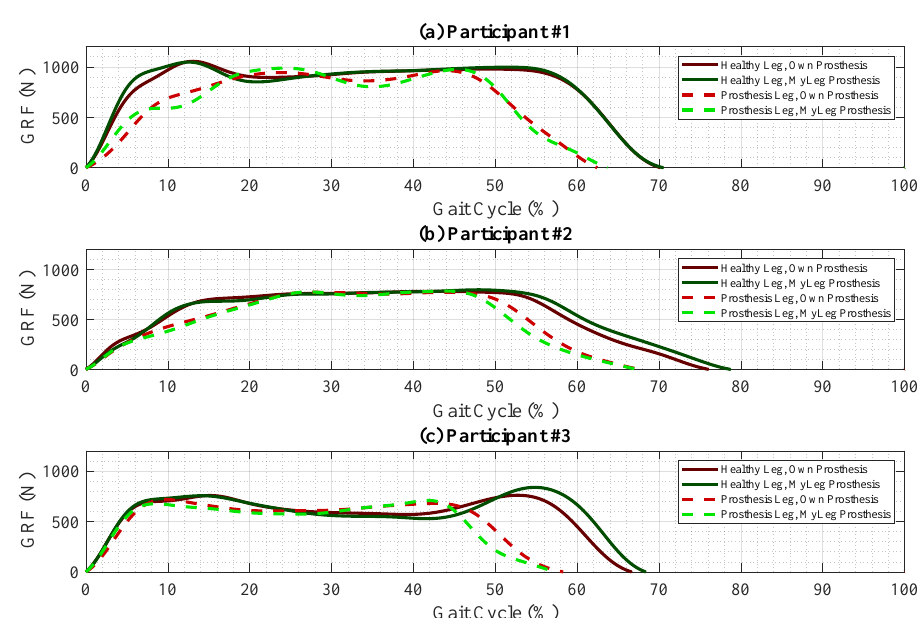
Figure 9. The ground reaction forces mean value calculated from 50 gait cycles of ( a ) Participant 1, ( b ) Participant 2 and ( c ) Participant 3: healthy leg, using their own prosthesis (dark red straight line); healthy leg, using MyFlex- δ (dark green straight line); prosthetic leg, using their own prosthesis (light red dashed line); prosthetic leg, using MyFlex- δ (light green dashed